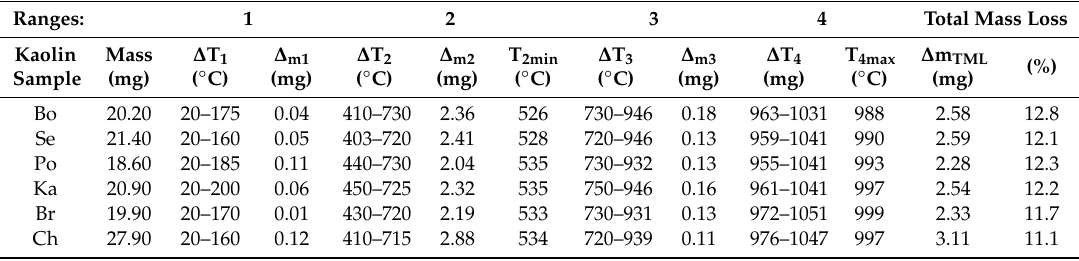
Table 2. TG / DTA of kaolin Table 2. TG/DTA of kaolin samples